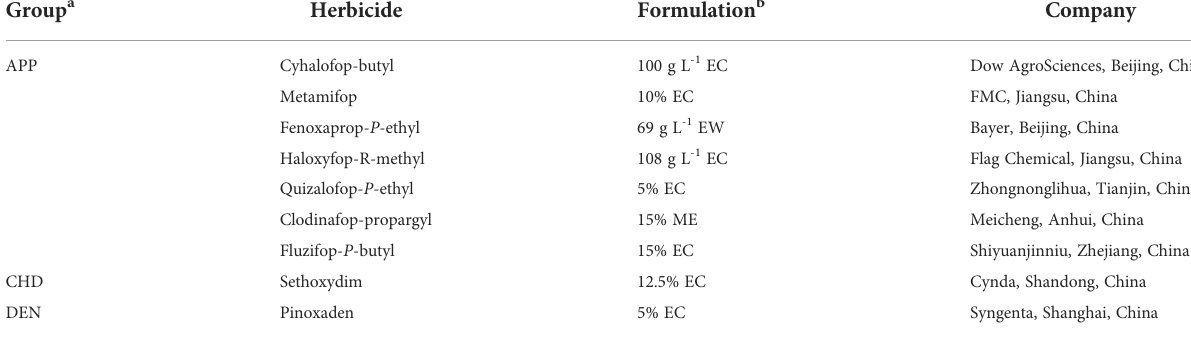
TABLE 1 ACCase-inhibiting herbicides applied for the bioassay. Group